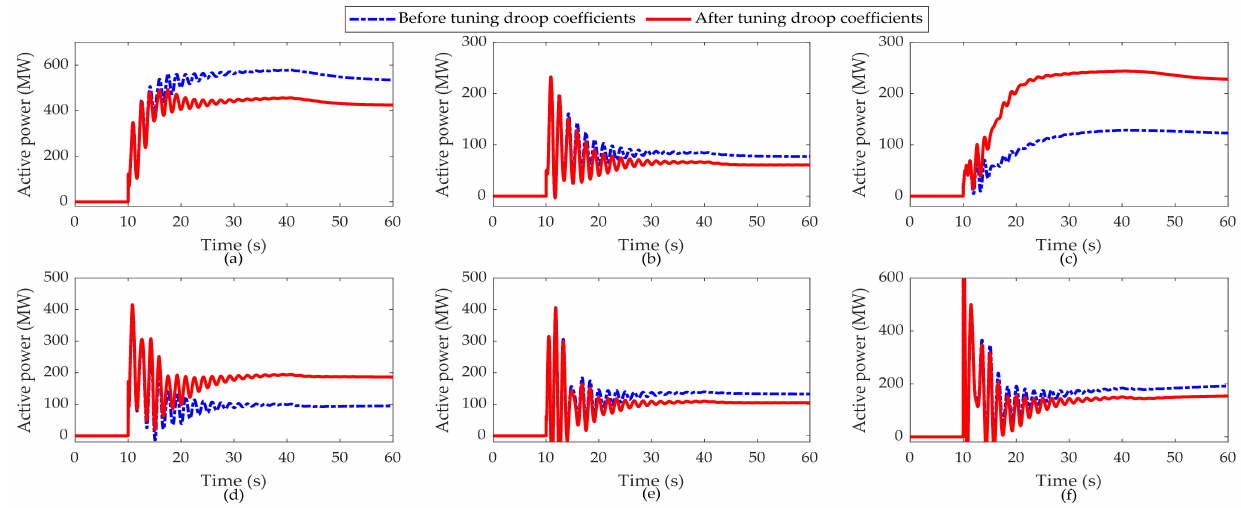
Figure 9. Total output power from SGs for case study 1. ( a ) Region 1, ( b ) Region 2, ( c ) Region 3, ( d ) Region 4, ( e ) Region 5, and ( f ) Region